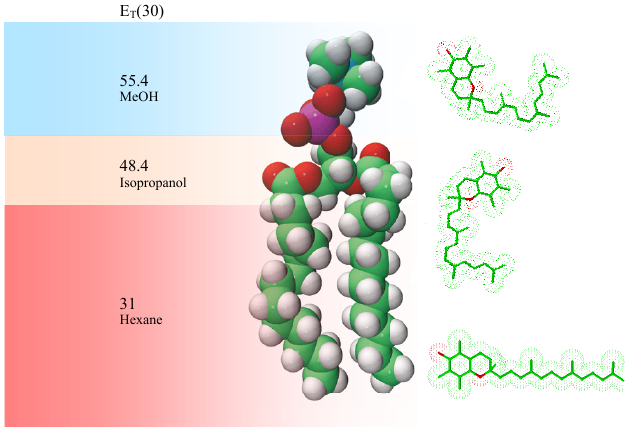
Figure 3. Cartoon representation of aToc’s location in a phospholipid bilayer along with the resulting polarity of the location and the representative solvent. Polarities along the lipid’s long axis were determined by Cohen, Afri, and Frimer